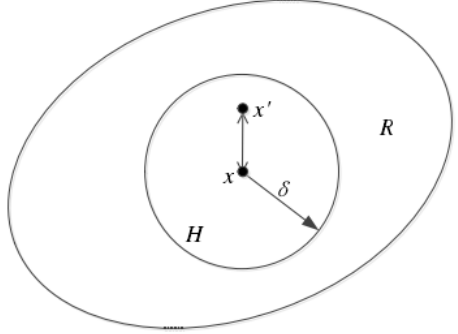
Figure 1. The peridynamic horizon of a material point ( H ), and the whole computing domain ( R ). Each material point only interacts with other material points in its neighborhood.